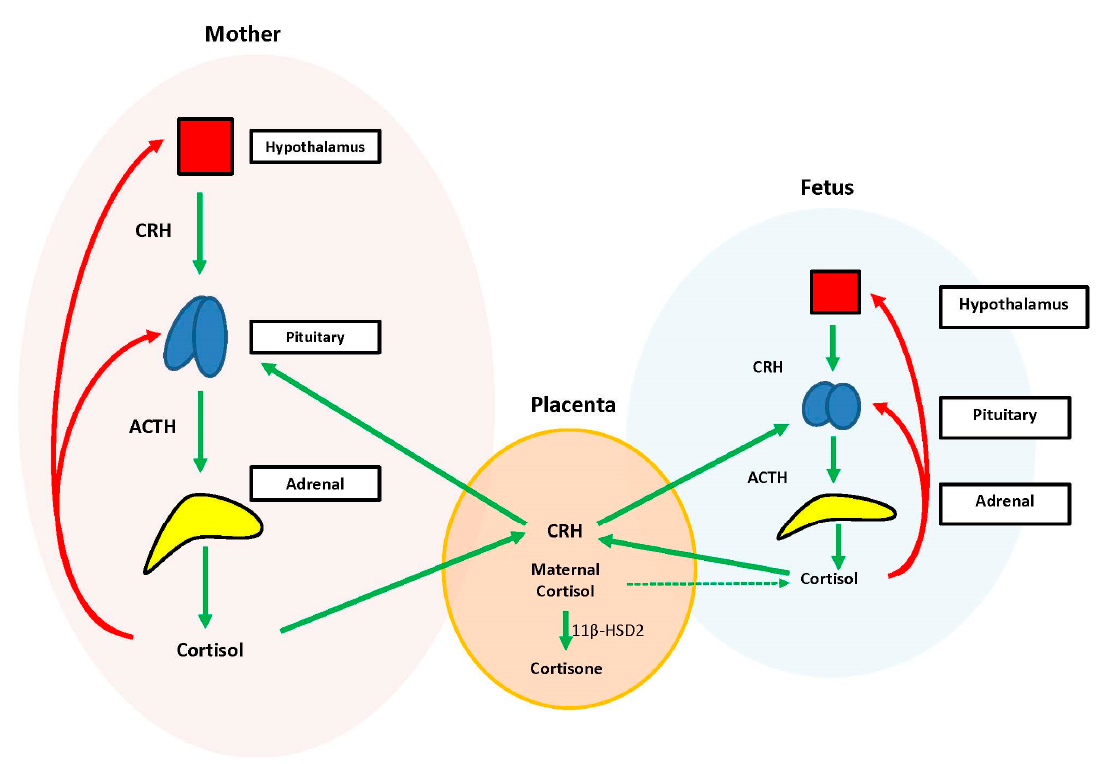
Figure 2. Maternal, placental, fetal unit. A representation of the hormone exchange between the maternal, fetal, and placental units. The maternal hypothalamic-pituitary-adrenal (HPA) axis stimulates cortisol production. Maternal cortisol is transferred to the placenta and converted into cortisone by 11 β -HSD2, with only minimal exposure of the fetus to cortisol (dashed green line). Maternal cortisol also stimulates production of placental corticotropin-releasing hormone (CRH), which in turn activates synthesis and release of additional maternal adrenocorticotropic hormone (ACTH), creating a positive feedback loop (green arrows). Placental CRH also enters the fetal circulation and stimulates release of ACTH, which allows for production of fetal cortisol. Fetal cortisol stimulates additional placental CRH production creating a second positive feedback loop. Excess cortisol inhibits production of CRH and ACTH both within the maternal and fetal units (red arrows). Figure was modified from the Howland et al. (2017) reference [33].